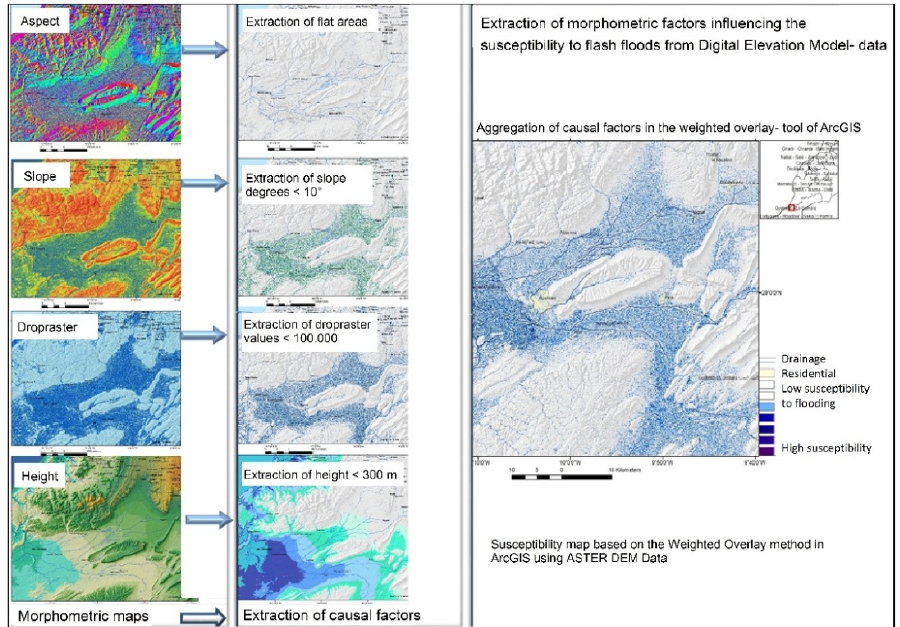
Figure 7. Weighted overlay of morphometric factors influencing the susceptibility to flooding. The resulting weighted overlay map is divided into susceptibility classes . The susceptibility to flooding is classified by values from 0 to 7, whereby 7 is the highest, assumed susceptibility to flooding due to the aggregation of causal morphometric/preparatory